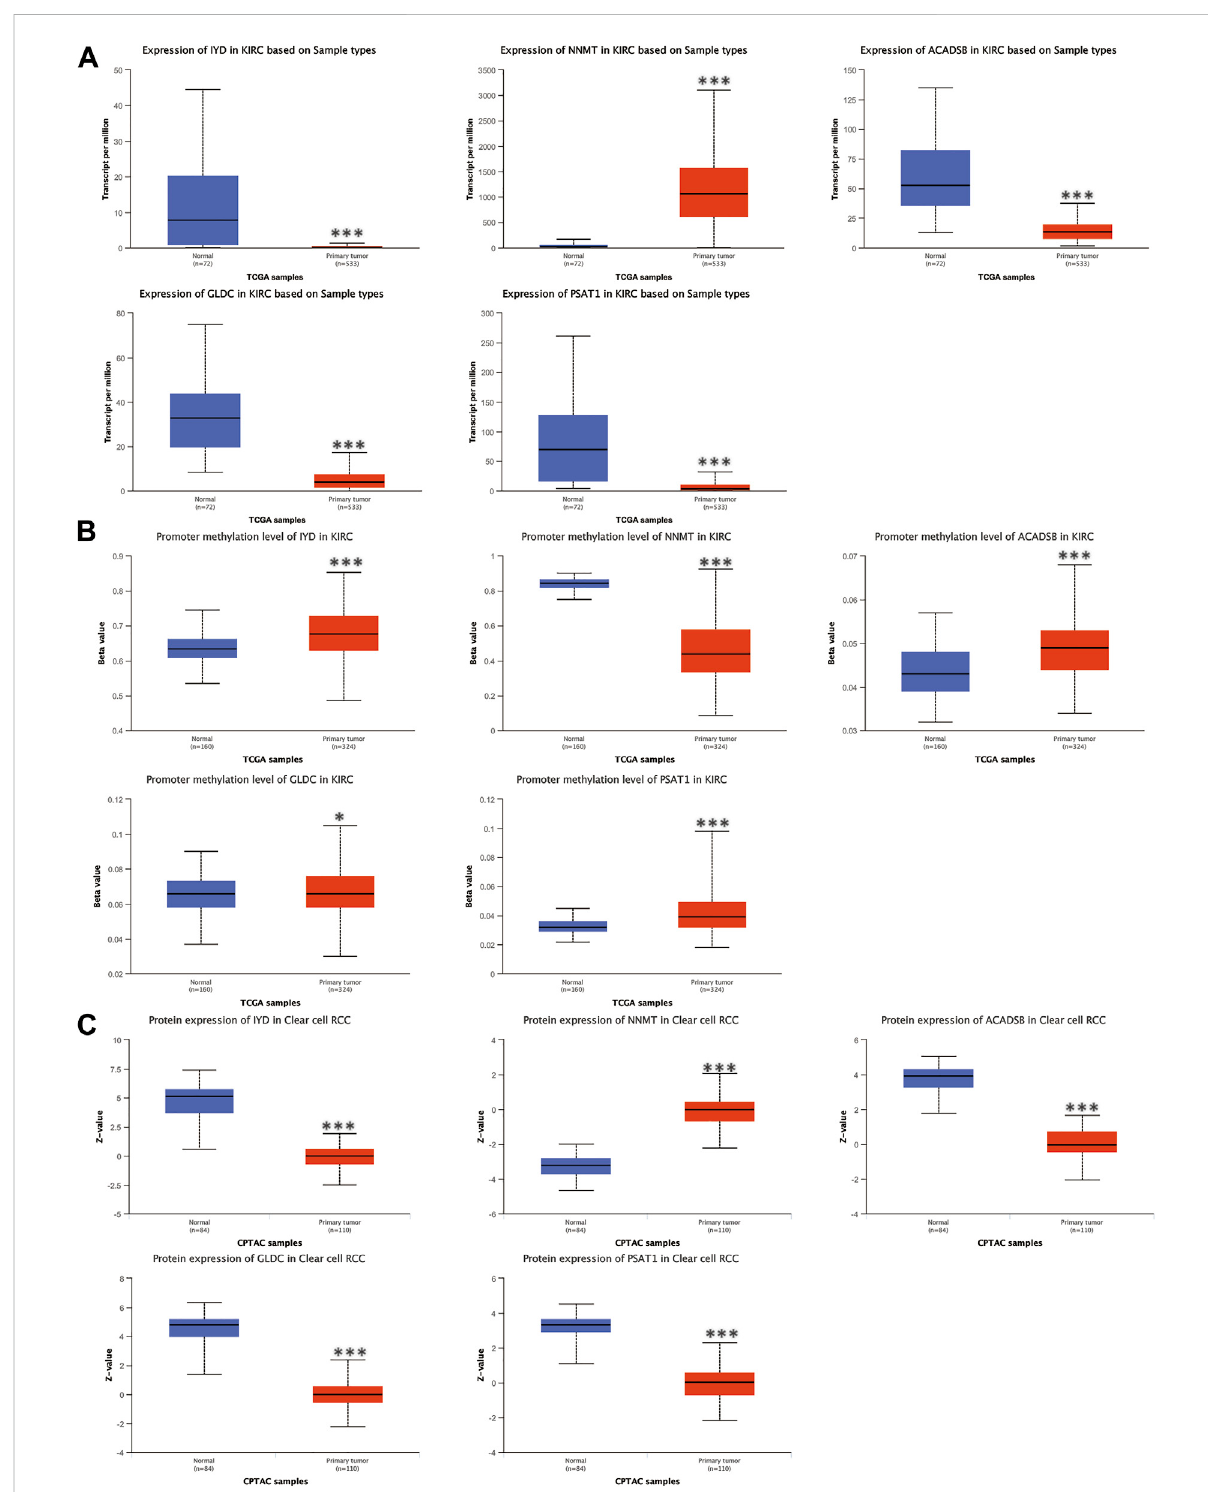
FIGURE 11 Validation of the mRNA expression levels (A) , promoter methylation levels (B) , and protein expression levels (C) of AAM-related prognostic genes via UALCAN database, ns: p ≥ 0.05; *: p < 0.05; **: p < 0.01; ***: p <